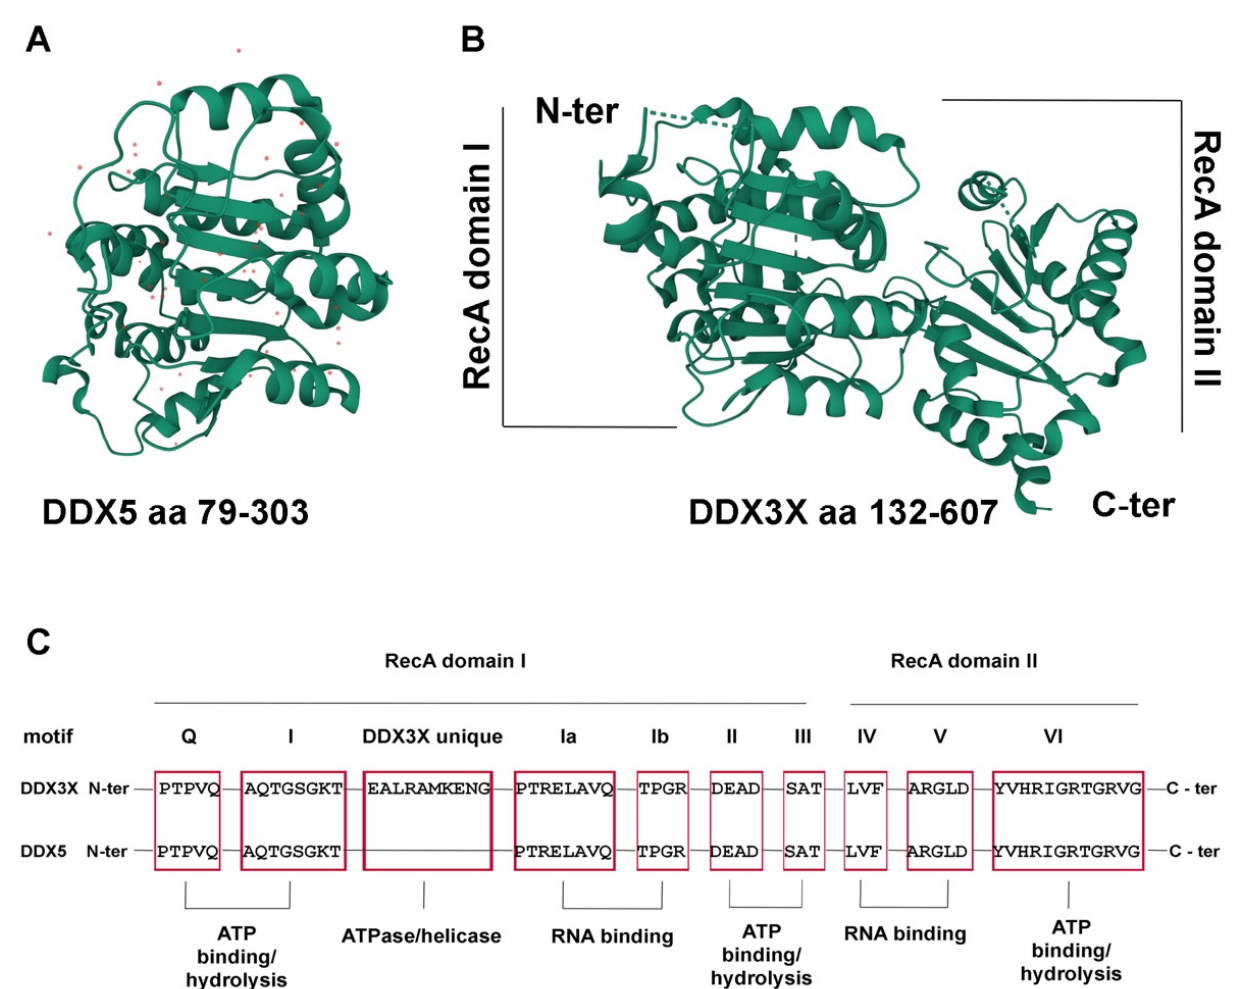
Figure 1. The DDX3X and DDX5 structure. ( A ) Structure of the DDX5 N-terminal core domain (aa 79-303), PDB 4a4d [3]. Red dots represent water molecules. ( B ) Structure of the DDX3X helicase core (aa 132-607), PDB 5E7I [4]. The N-terminal domains of DDX5 and DDX3X are shown in the same orientation to highlight the conserved RecA fold of both proteins. Images were generated by the authors with the online tool Mol*3D viewer (https://www.rcsb.org/3d-view, accessed on 1 August 2022) [5]. ( C ) Schematic representation of the conserved helicase motifs of DDX3X and DDX5 (red boxes) with the respective functional roles.